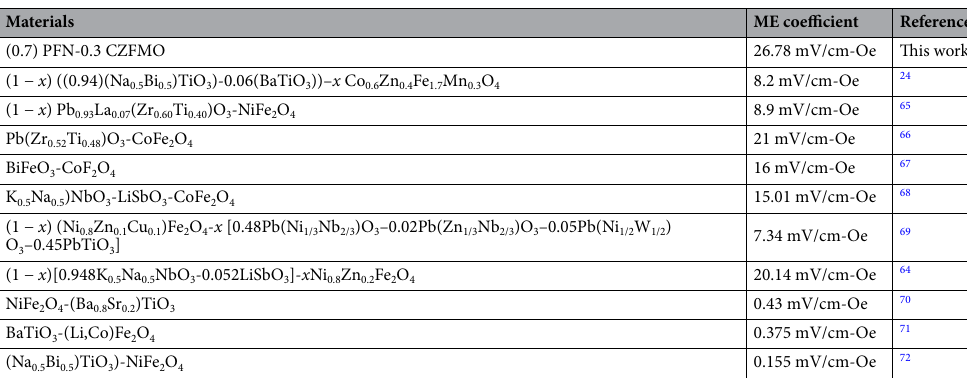
Table 4. Comparison of ME coupling coefficient of (1 − Φ) PFN-Φ CZFMO (Φ = 0.3) with other composite